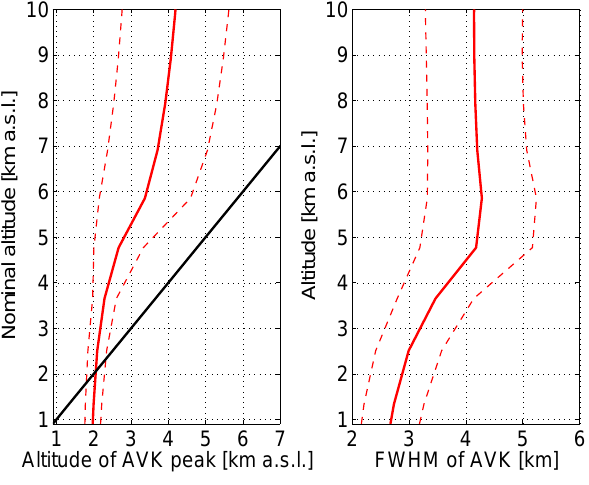
Fig. 7. Average (solid) and variation range (dashed) using 4h aver- aged spectra from 2007–2010 of left: peak altitude against nominal altitude of AVKs, right: full width at half maximum of the AVKs. The black line in the left plot indicates the ideal case (correct alti- tude